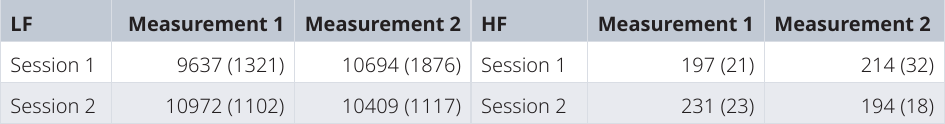
Table 3. Mean high-frequency (HF) and low frequency (LF) spectral values and standard error of the mean (in parenthesis) in ms 2 /hz for all the sessions and measures.